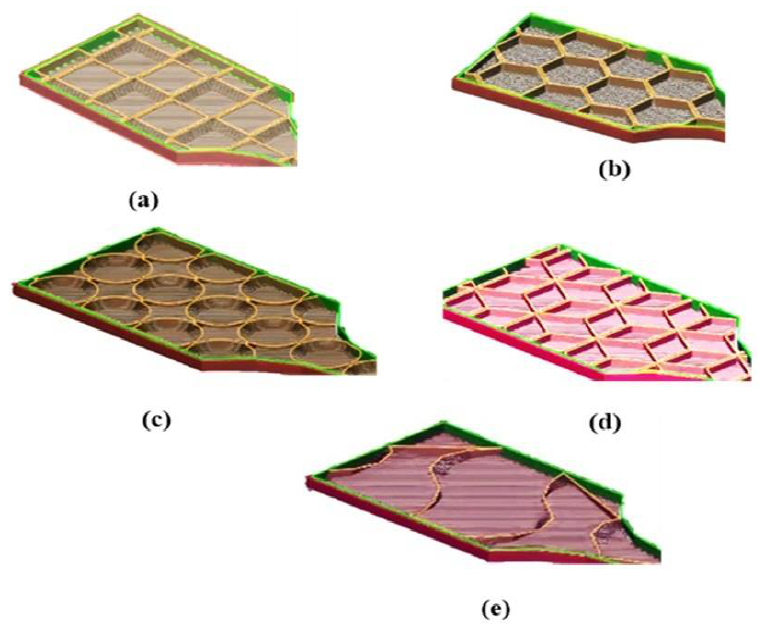
Figure 3. ( a ) Truncated octahedron infill structure, ( b ) Hexagonal infill structure. ( c ) Circular infill structure, ( d ) Rhombile infill structure, ( e ) Gyroid infill structure.